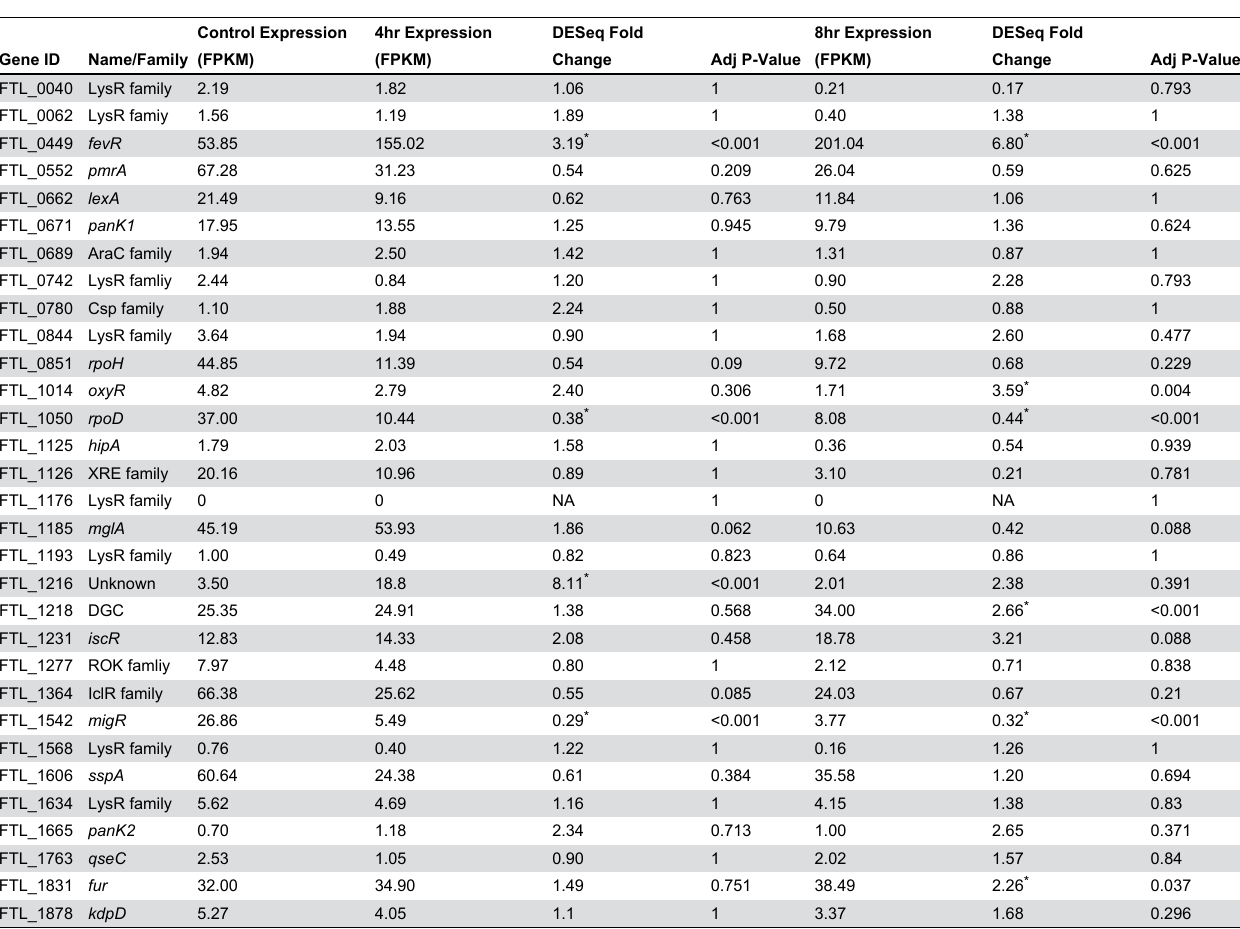
Table 2. Expression of known and putative transcriptional regulators.